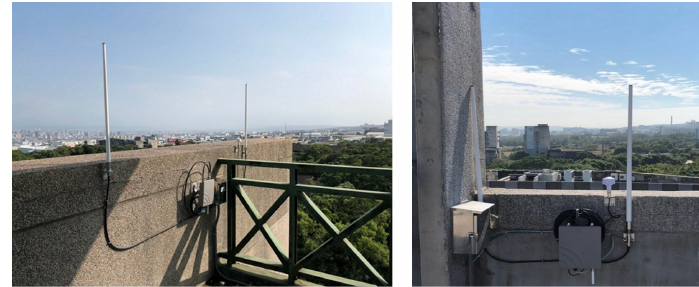
Figure 6. LoRa Gateway Installation.